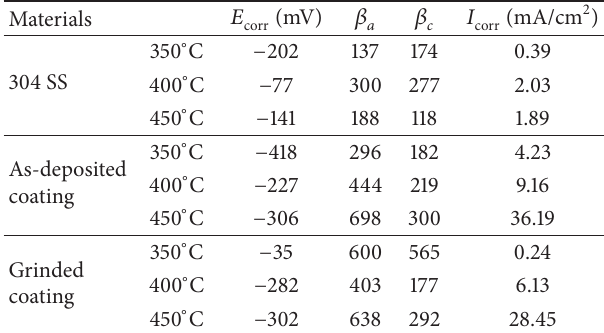
Table 1: Electrochemical parameters of potentiodynamic polariza- tion